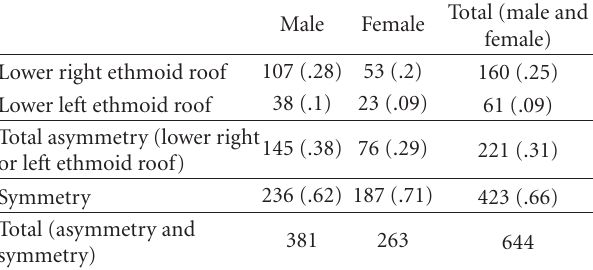
Table 1: Distribution of the height of the ethmoid roof with respect to asymmetry and symmetry in the sample (relative values in